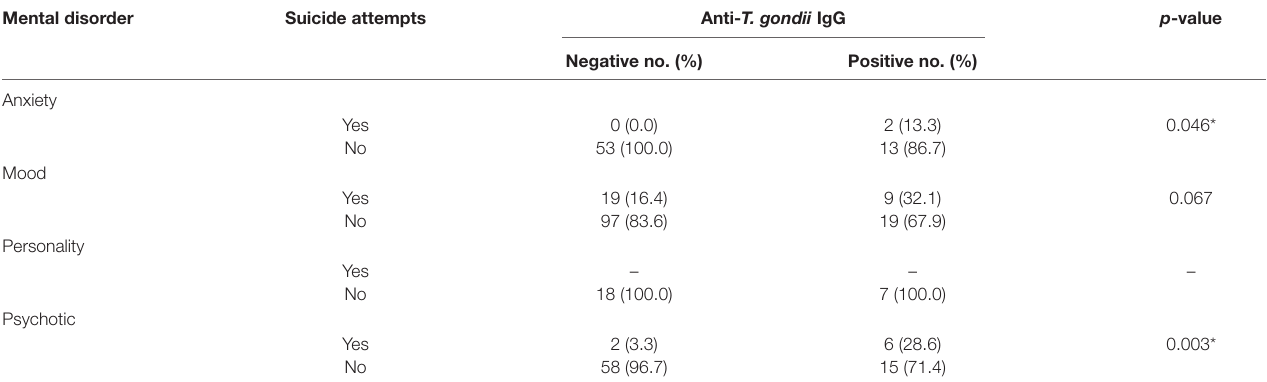
TABLE 3 | Association between suicide attempts and T. gondii seropositivity in 318 psychiatric